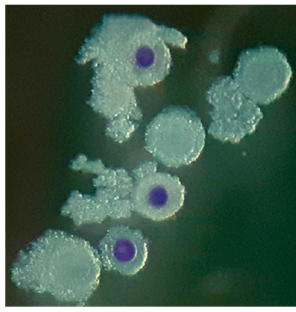
Figure 1. High quality cumulus oocyte complexes, collected from ovaries of anestrus cats, stained by Brilliant Cresyl Blue (BCB).